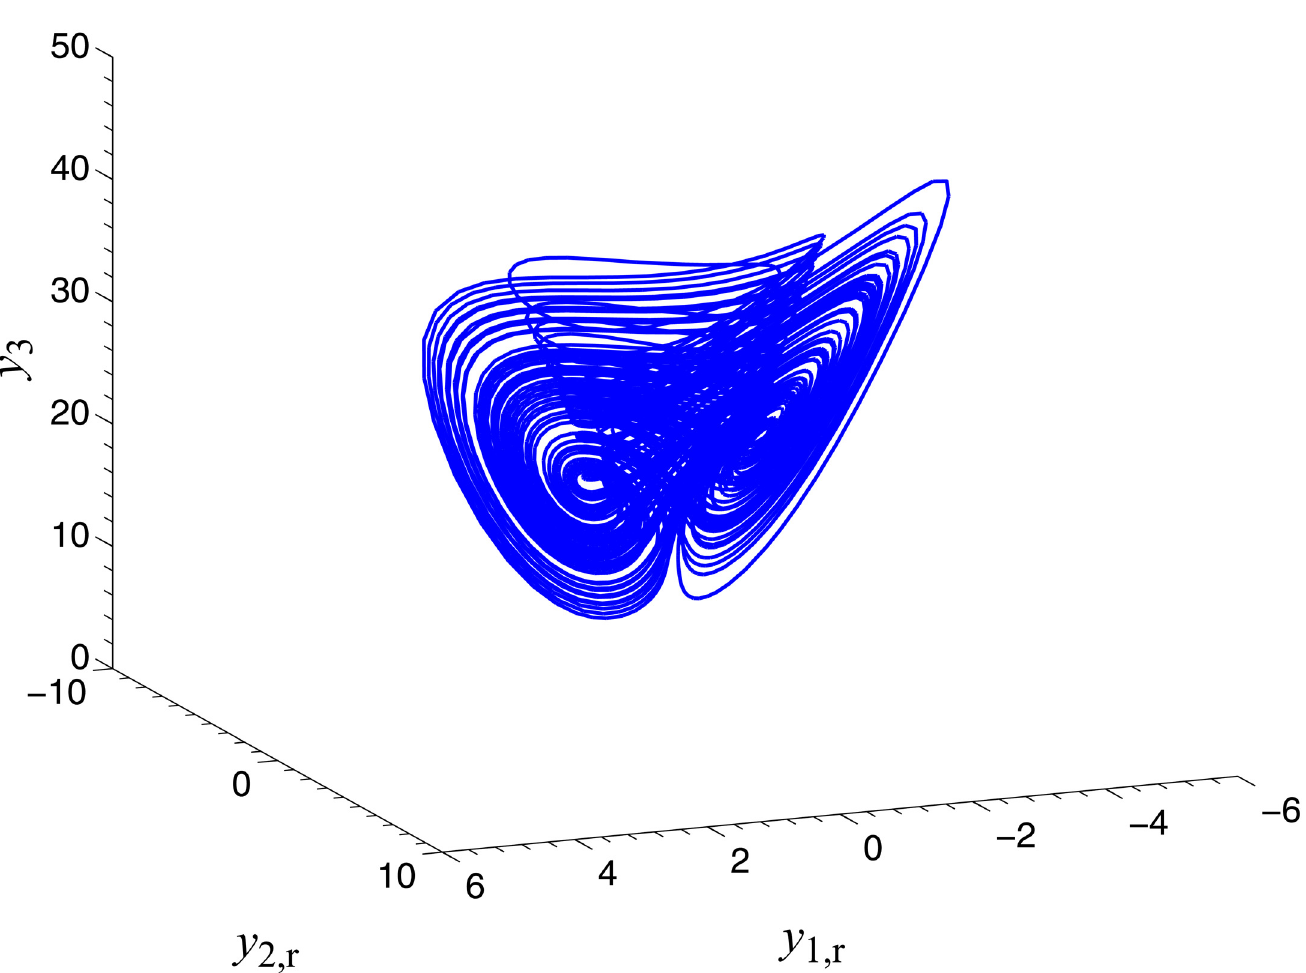
Fig 10. Chaotic attractor of the complex Lü